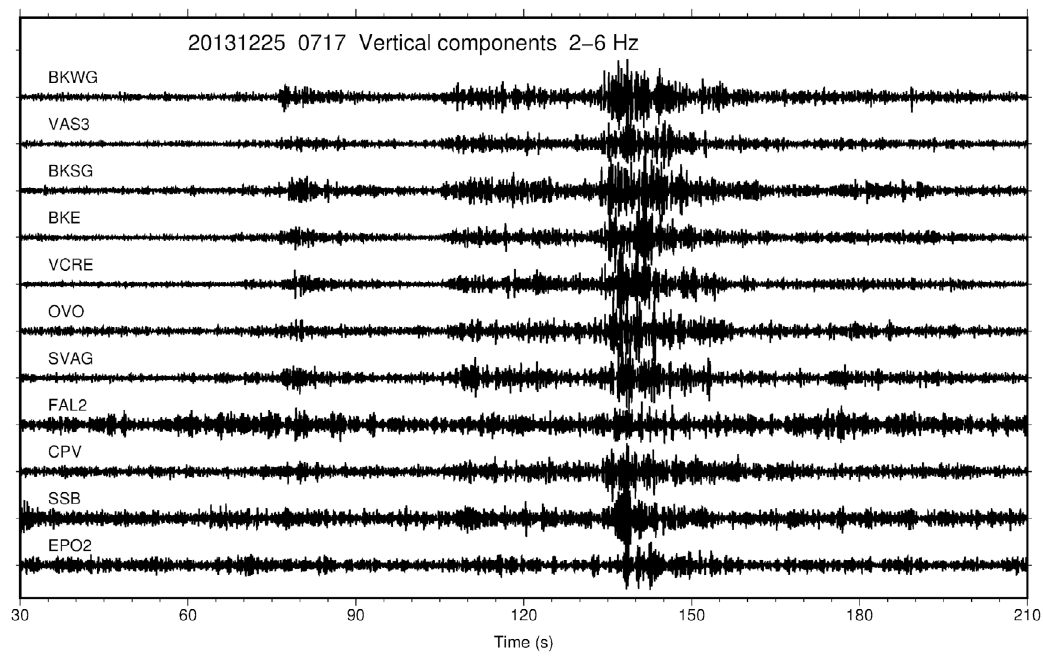
Figure 13. The volcanic tremor shown in Figure 12 as recorded by many of the seismic stations installed on Mt. Vesuvius. Vertical compo- nent seismograms, bandpass filtered between 2 Hz and 6 Hz, are shown with epicentral distance increasing from top to